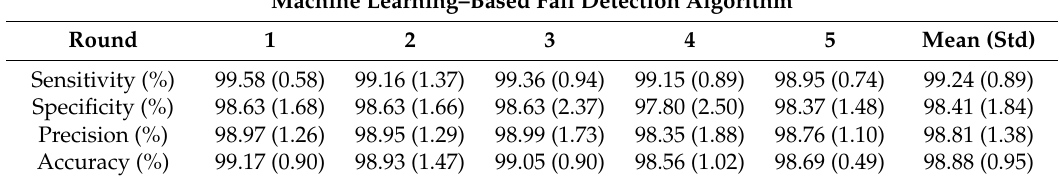
Table 5. The overall performance of five-fold cross-validation over five rounds for the machine learning–based fall detection